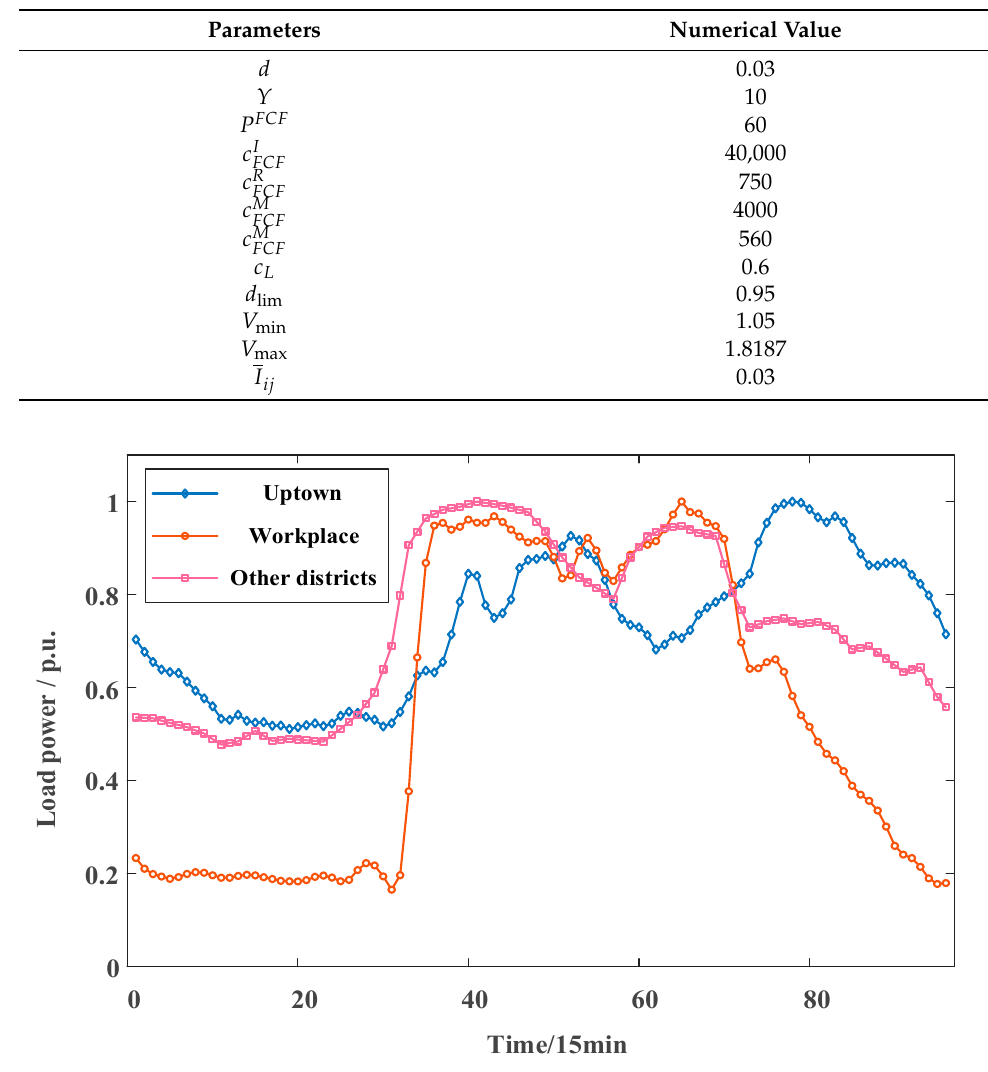
Figure 5. Typical daily conventional load curve.